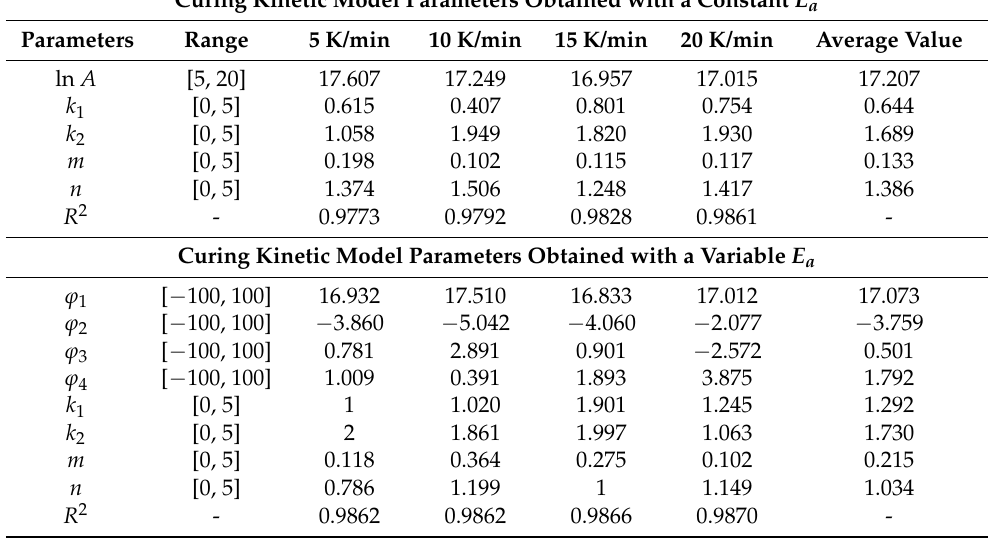
Table 2. Kamal autocatalytic model parameters of thermal curing.